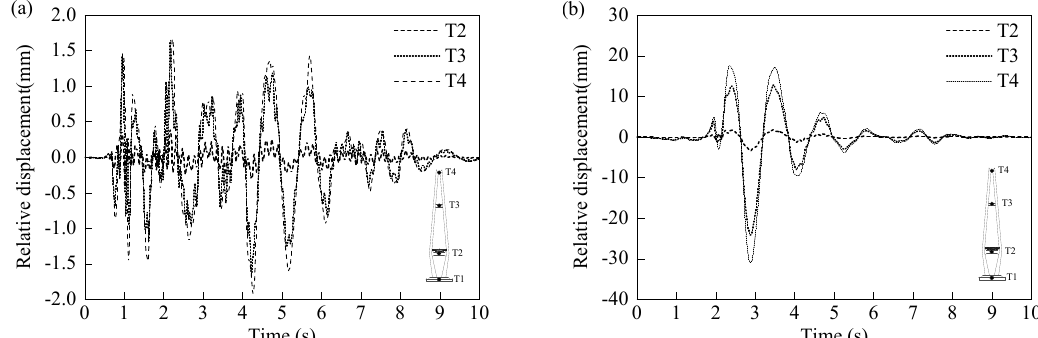
Figure 16. Relative displacement time history response of 3# tower ( a ) under ScEL; ( b ) under ScTCU.